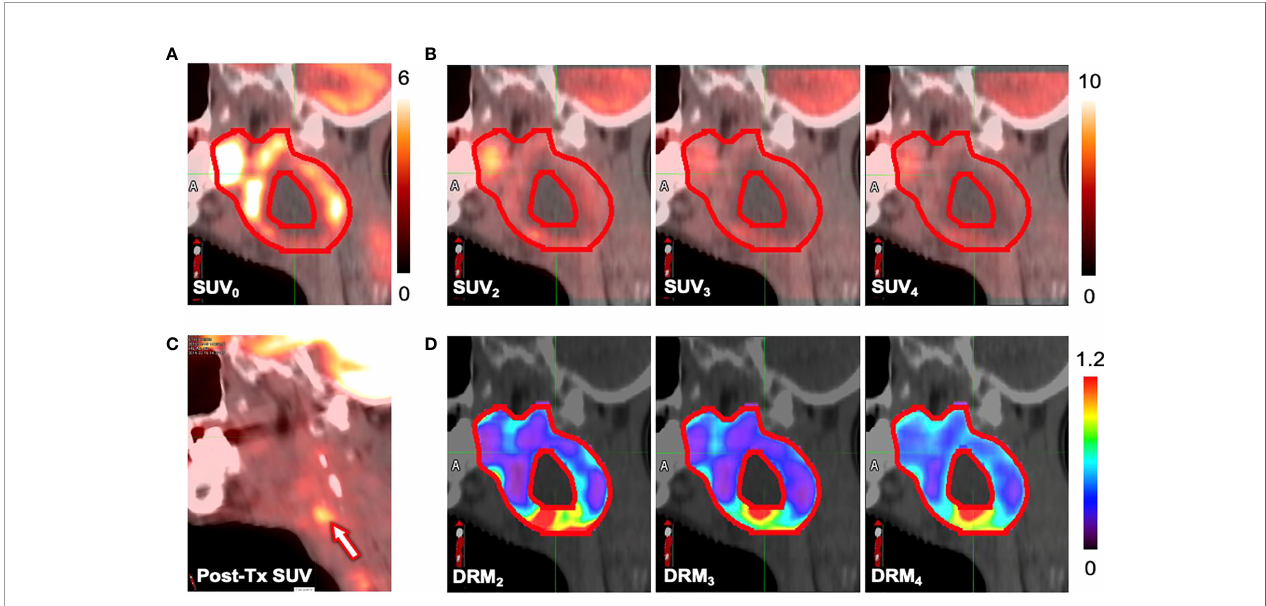
FIGURE 8 | Standard uptake values (SUVs) measured at (A) the pretreatment (SUV 0 ), (B) the i th treatment week (SUV i ), and (C) the 6-month posttreatment. (D) The dose – response matrix (DRM) estimated using single feedback image for a patient (primary site: tonsil, stage IV, HPV − ) who experienced local